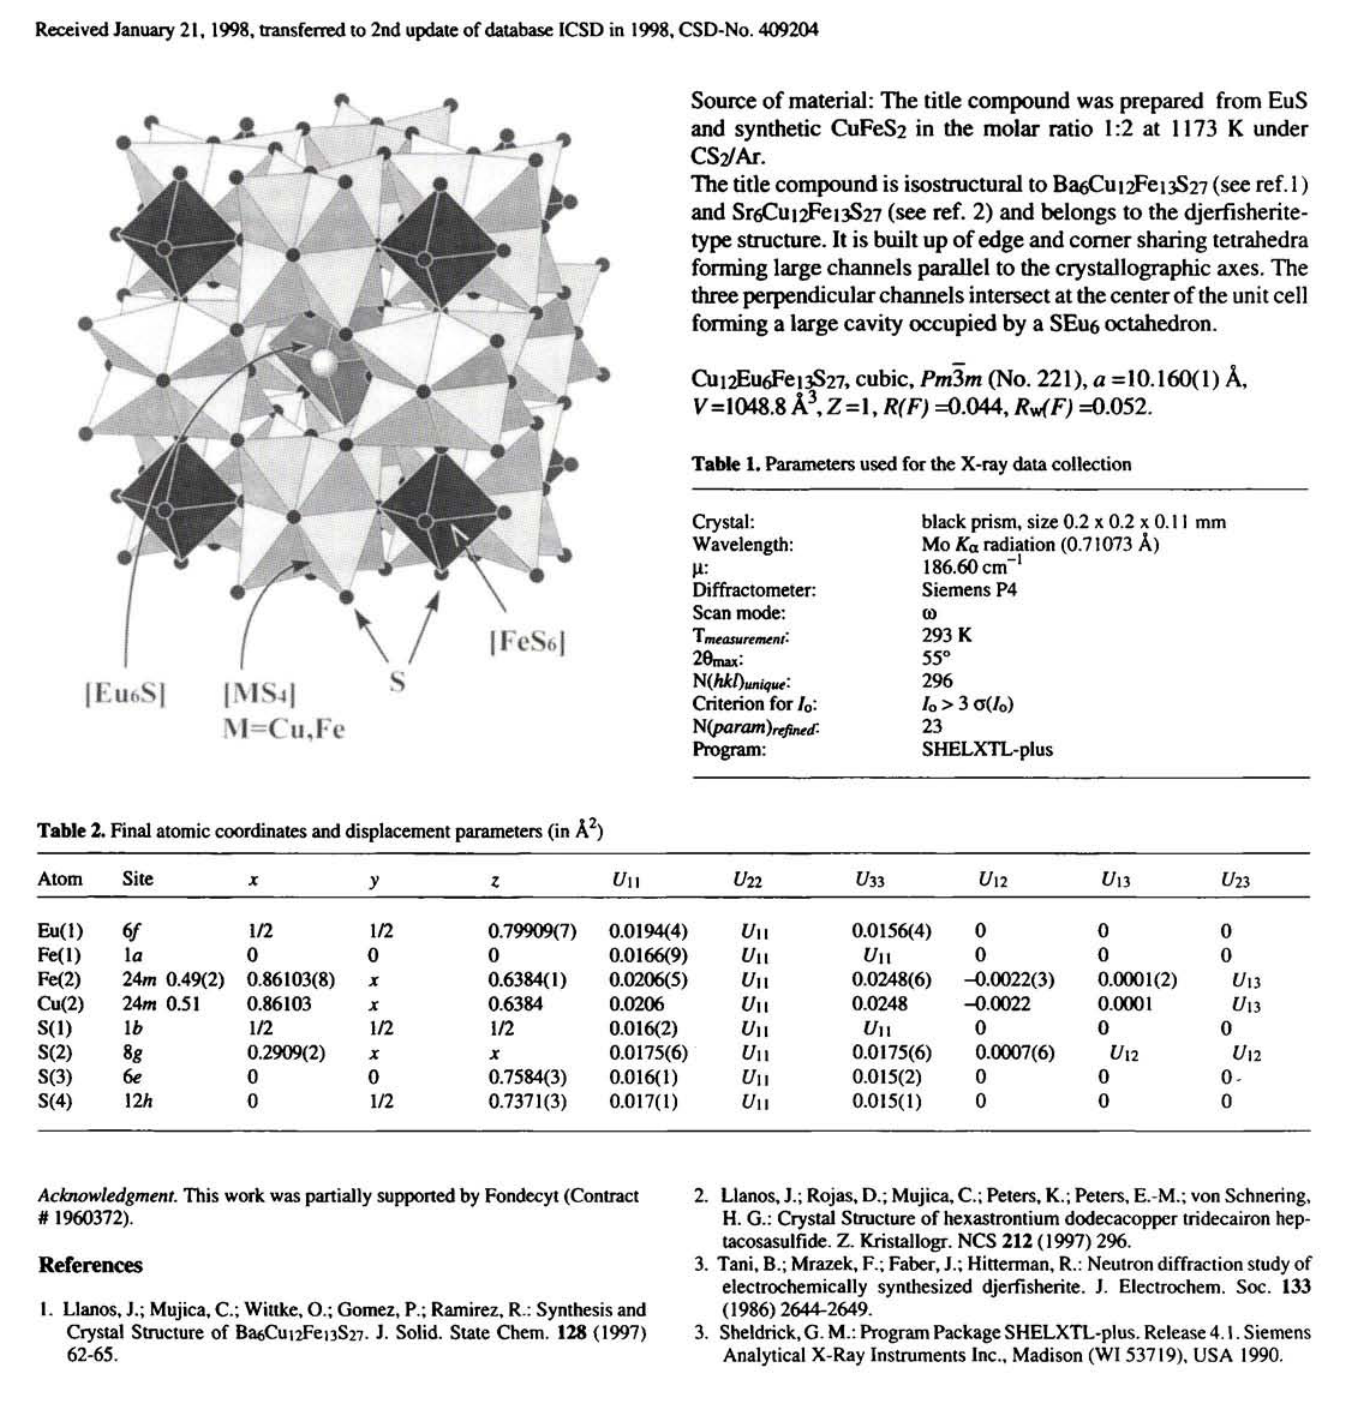
Table 2. Final atomic coordinates and displacement parameters (in